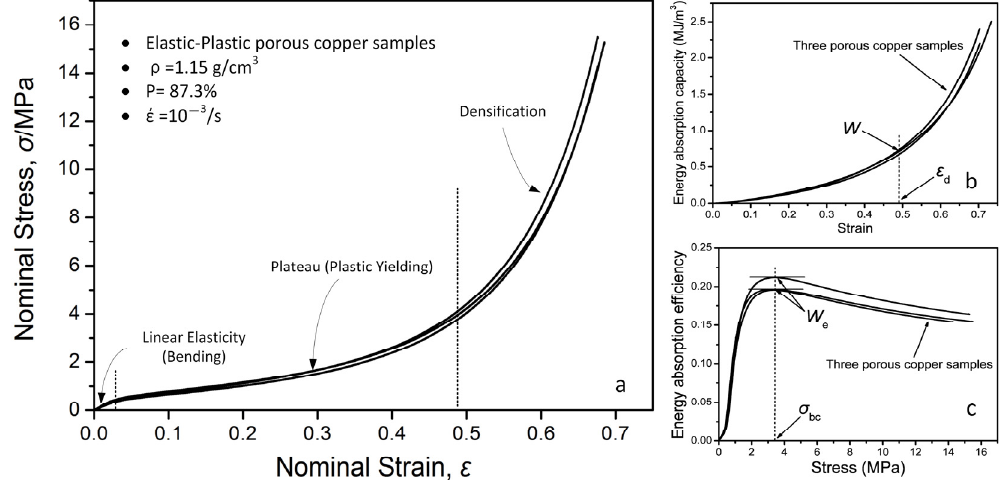
Figure 4. Mechanical curves of the samples: ( a ) Stress–strain, ( b ) W -strain, ( c ) W e -stress. The mean values with their standard deviations of mechanical properties of the ob- tained porous copper samples were calculated and shown in Table 1. Herein, E -Elastic is modulus; σ ys is yield strength; σ pl is plateau strength; σ bc is compressive strength, which was the stress corresponding to the maximum energy absorption efficiency; ε d is densi- fication strain; W is energy absorption capacity; and W e is energy absorption efficiency.